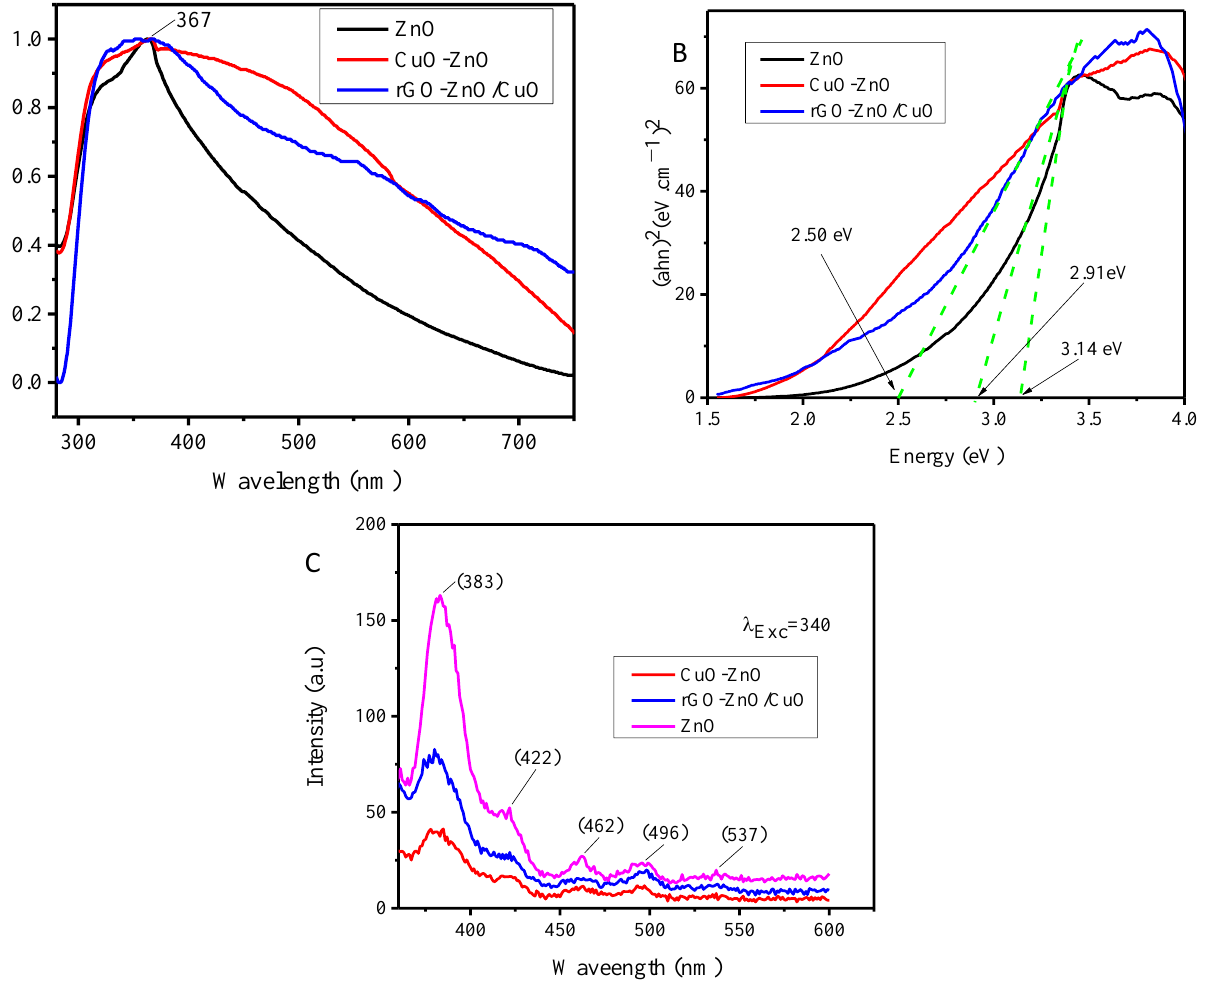
Figure 4. ( A ) UV–vis absorbance spectra, ( B ) Tauc’s plot, and ( C ) PL spectra of ZnO, CuO-ZnO, and (rGO-ZnO)/CuO samples.